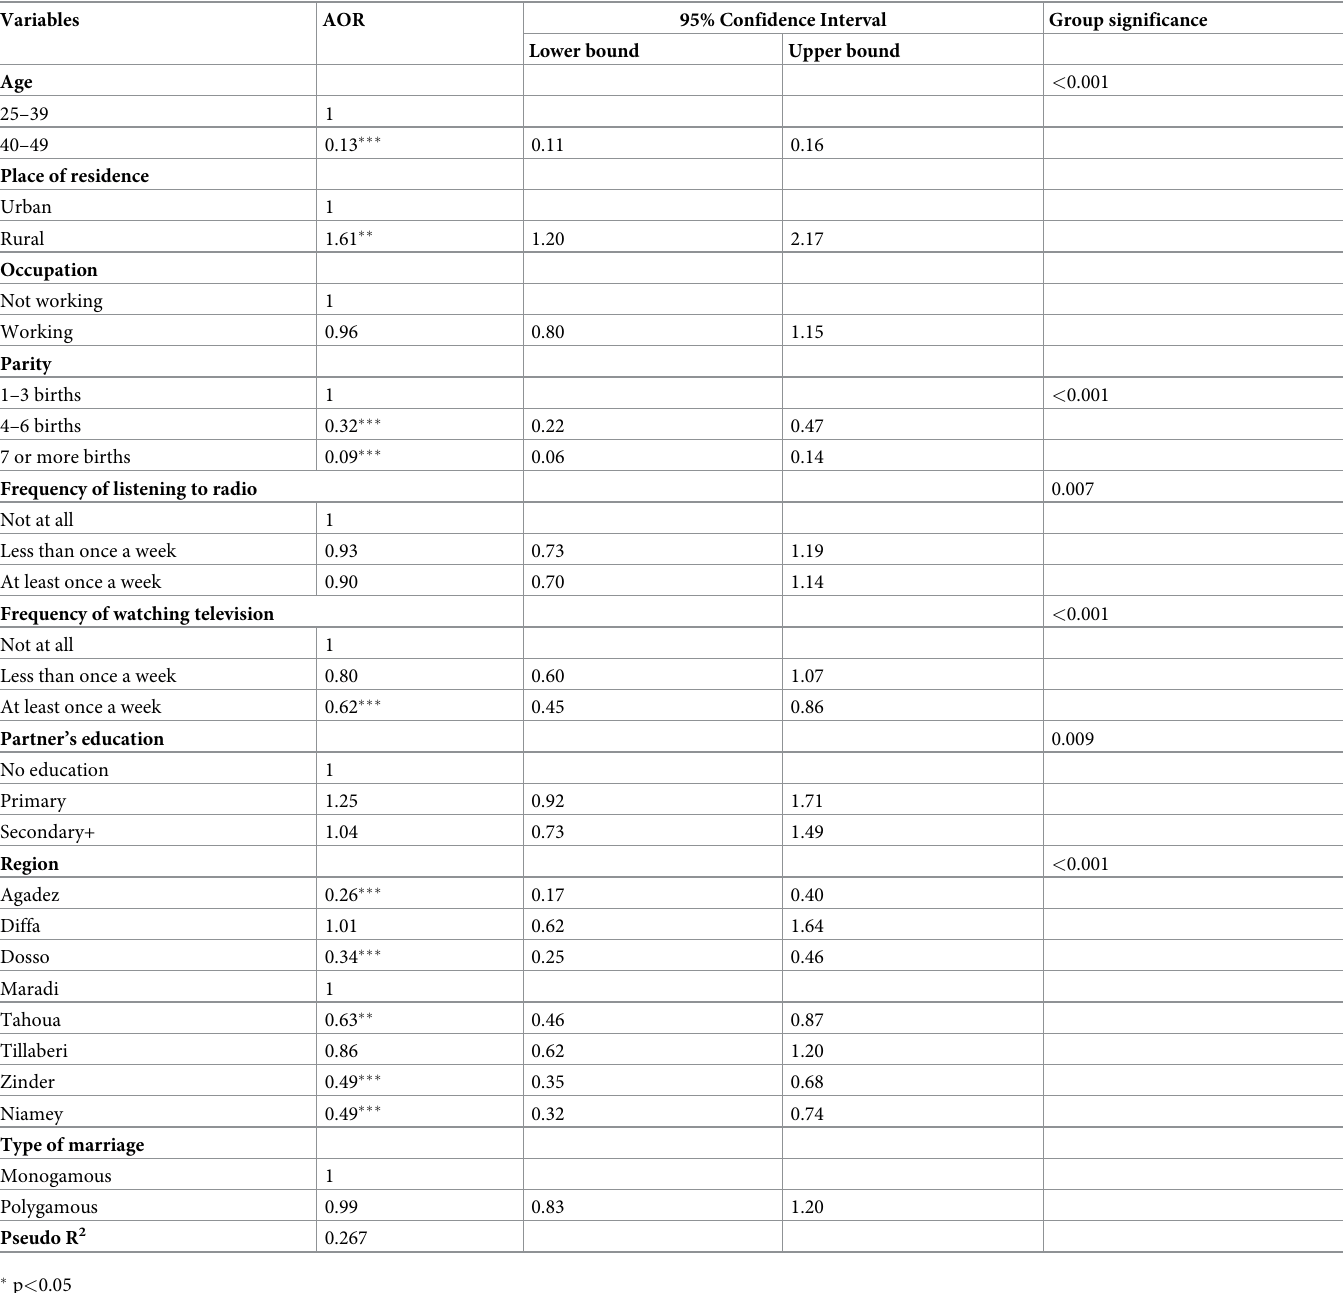
Table 3. Binary logistic regression analysis on predictors of wanting more children among women in